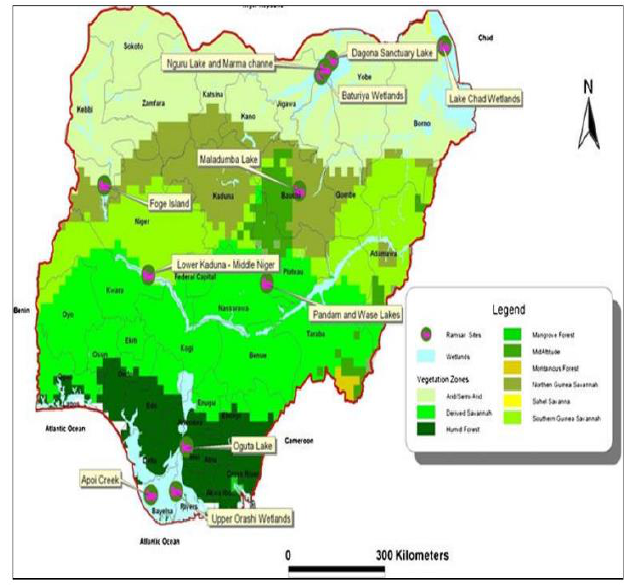
Figure 2: Map of Nigeria showing the Ramsar sites. (Source: Adekola et al.,